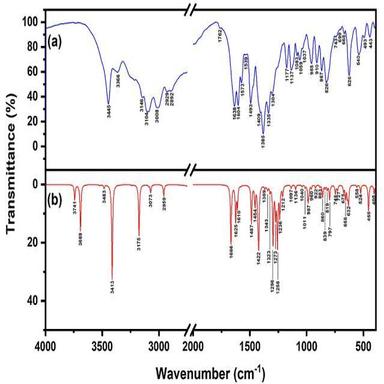
Comparison of (a) observed and (b) simulated FT-IR spectra of the PCOH.